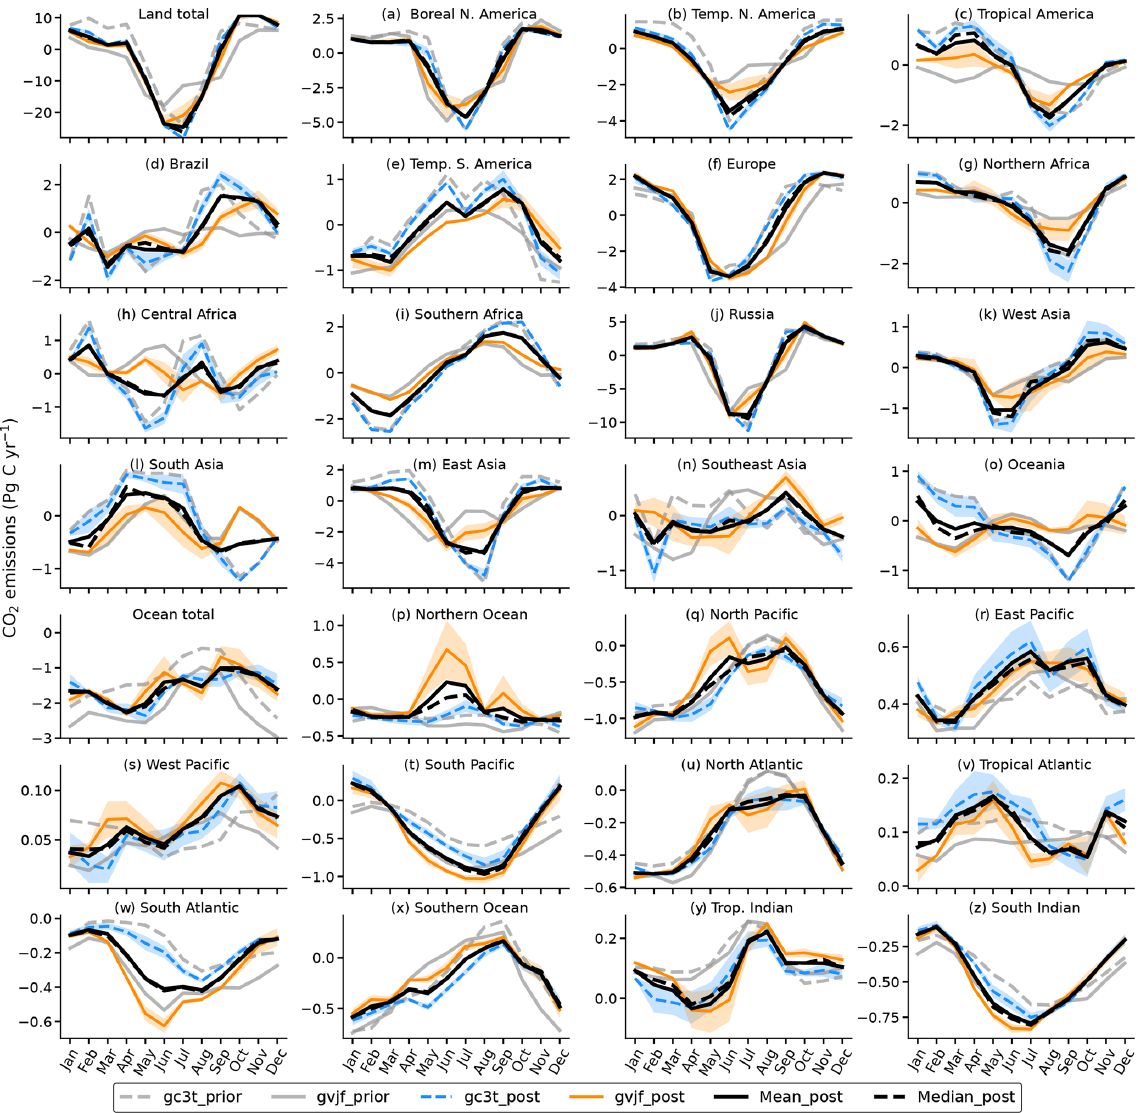
Figure 9. Seasonal variations in monthly-mean CO 2 fluxes at regional scales over 15 lands (upper four rows) and 11 oceans (lower three rows) regions, along with global land and ocean totals. We prepare the average (2001–2020) separately for inversion ensemble cases based on gc3t (broken line) and gvjf (solid line) prior. The shade around means shows ± 1 σ SDs for the respective inversion cases. The individual inversion cases are plotted in the Supplement (Fig. S2). Note that all panels use different y